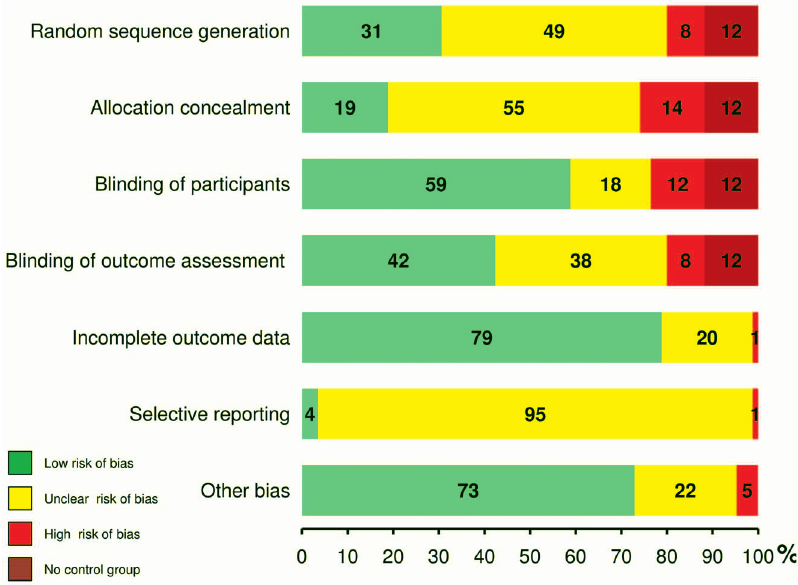
Fig. 2. Risk of Bias Assessment. Results of the risk of bias assessment as depicted in table 4 are summarized. Percentages of studies with ‘low risk of bias’, ‘high risk of bias’, or ‘unclear risk of bias’ are illustrated for each item of the Cochrane Collaboration’s